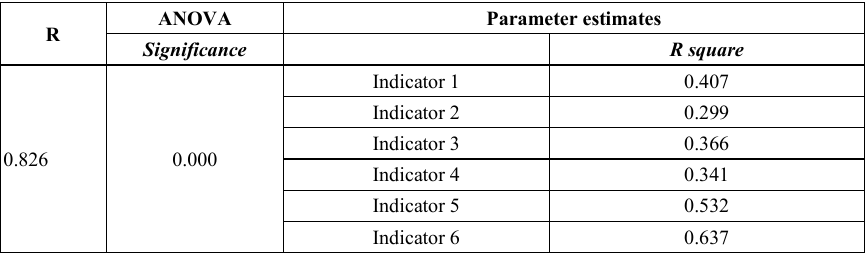
Table 1. Estimation of the independent indicators on the dependent